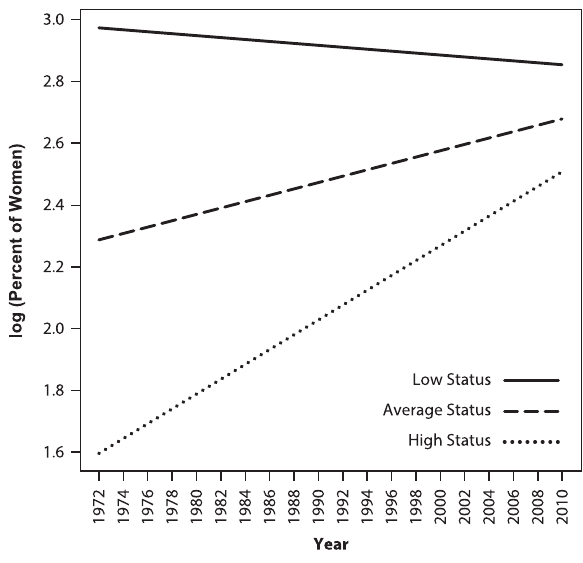
Figure 3. Simple slope plots of percent of women in low, average, and high-status occupations in MLM Model 2. Low- status occupations were defined as one SD below the mean, average- status occupations as at the mean, and high-status occupations as one SD above the mean status level of all occupations. Status was defined in terms of mean student ratings of occupations’ income and status levels.